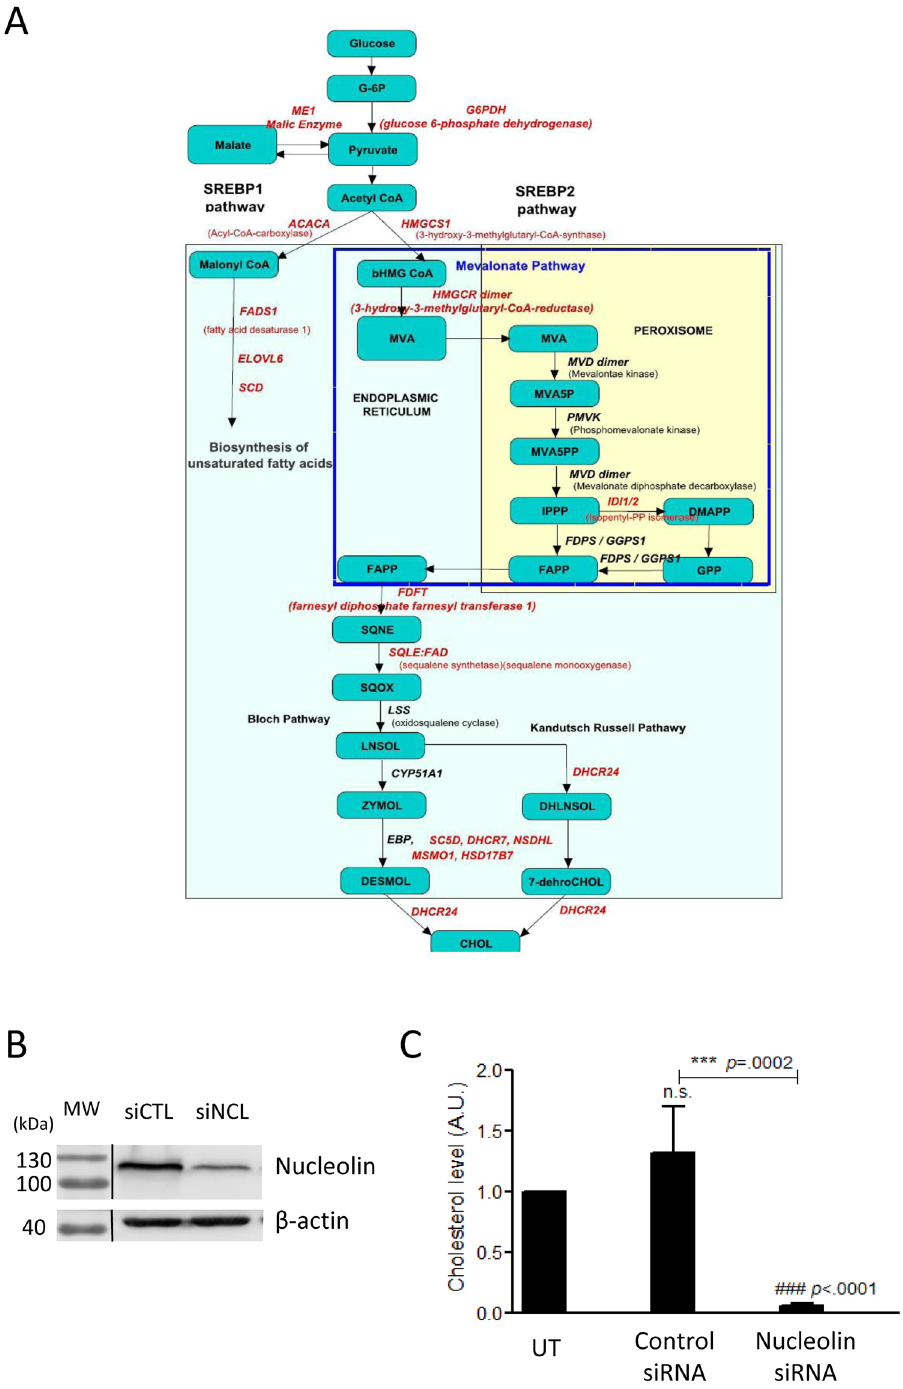
Figure 4. NCL expression affects cholesterol synthesis. ( A ) The different enzymes of the cholesterol biosynthetic pathways that are down regulated in the NCL siRNA treated cells are indicated in red on the scheme of the cholesterol synthesis pathway. ( B ) Western blot to detect nucleolin and β actin in cells transfected either with control siRNA or siRNA targeting nucleolin. Total extracts were used and loaded onto a 10% SDS-PAGE. ( C ) Cholesterol dosage from untransfected (UT), control siRNA or nucleolin siRNA treated cells. Assays were performed in triplicates for each condition, and samples were processed as recommended by the manufacturer. Results were expressed compared to untransfected